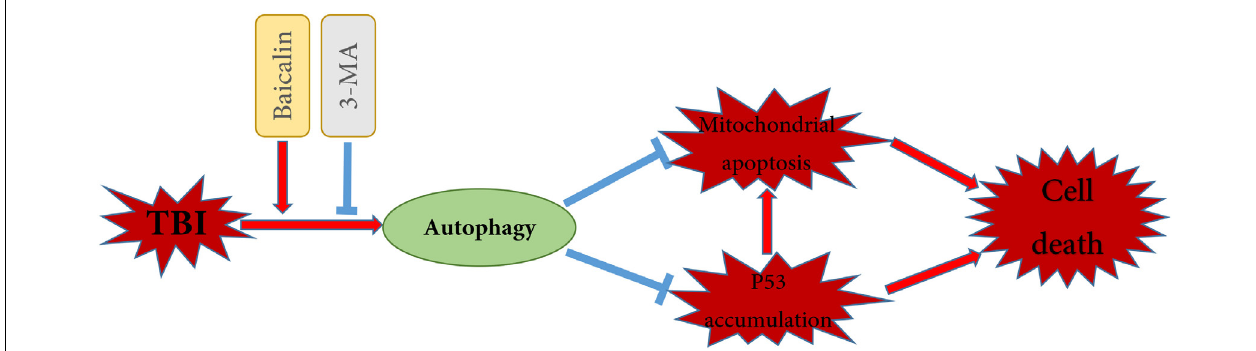
FIGURE 6 | Schematic illustration of the possible neuroprotective mechanisms of Baicalin administration after TBI. As illustrated, Baicalin enhanced TBI-induced autophagy, leading to the reduction of p53 accumulation and the inhibition of mitochondrial apoptosis. In contrast, inhibition of autophagy by 3-MA aggravated p53 accumulation and mitochondrial apoptosis, exacerbating cell death. The red arrows indicate induction, while the blue blocked lines indicate repression.